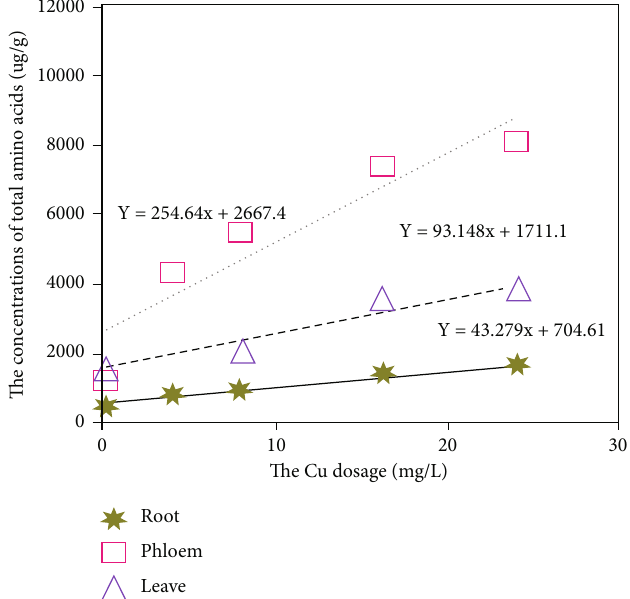
Figure 7: Linear relationship between amino acid content and Cu concentration in di ff erent parts of